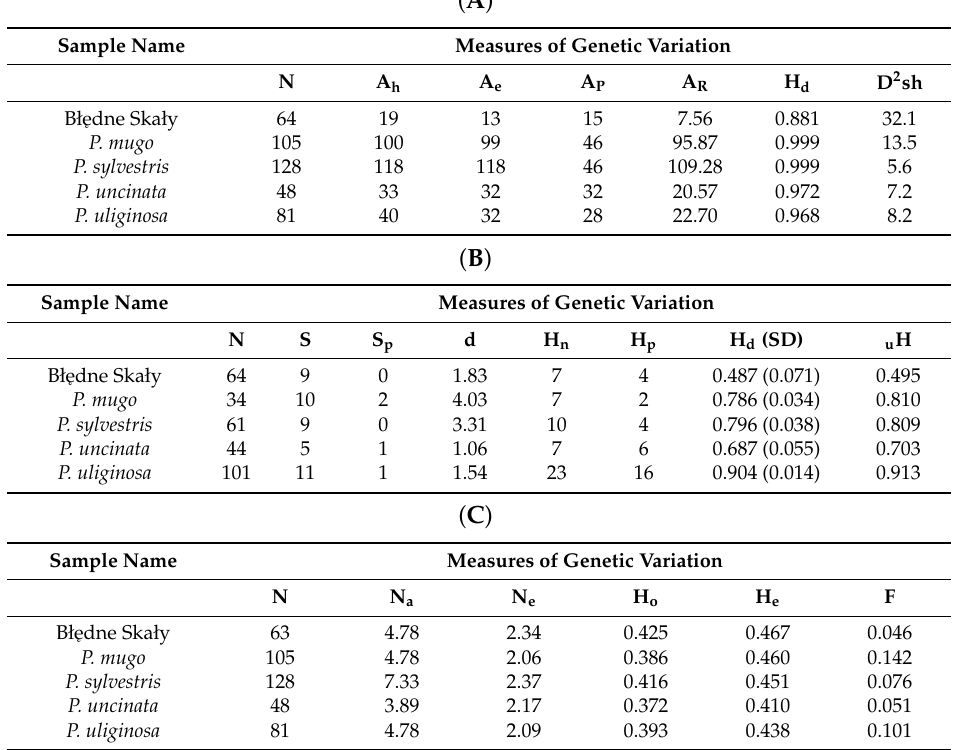
Table 2. Genetic variation of samples from mixed pine population in Bł˛edne Skały and four reference pine species based on: ( A ) chloroplast microsatellite (cpSSR) loci; ( B ) mitochondrial (mtDNA) markers; ( C ) nuclear microsatellite (nSSR)